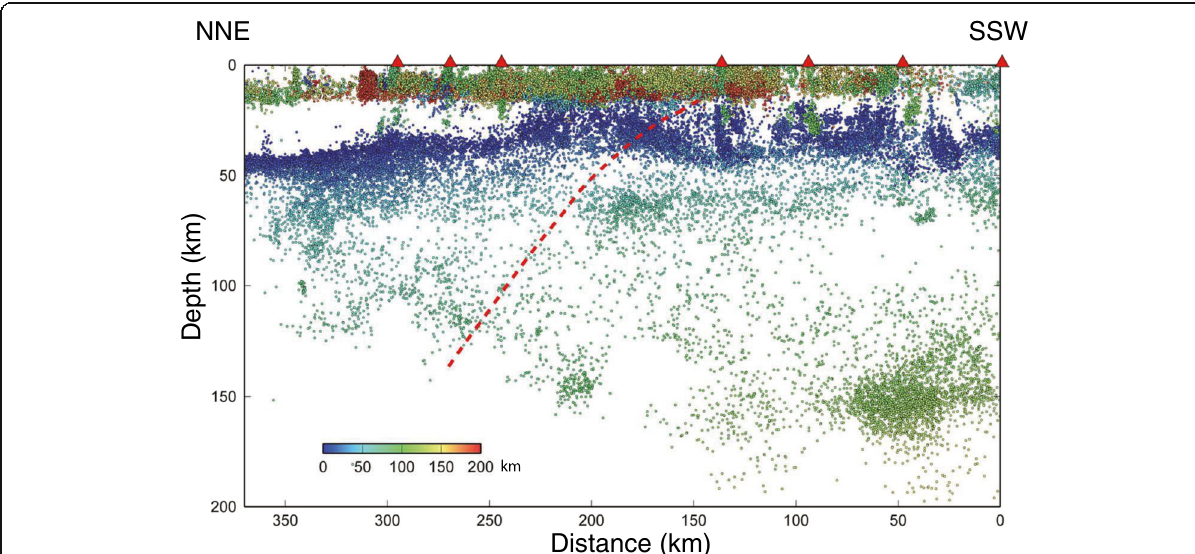
Fig. 13 Along-arc vertical cross-section of earthquakes beneath Kyushu. Earthquakes that occurred in the rectangular region shown in Fig. 12 are shown as circles . The distance of each event from the east-southeastern edge of the rectangular region is shown as the color scale . The estimated northeastern prolongation of the Kyushu – Palau ridge from the top of the slab is shown as the thick , broken red line. Red triangles at the top denote